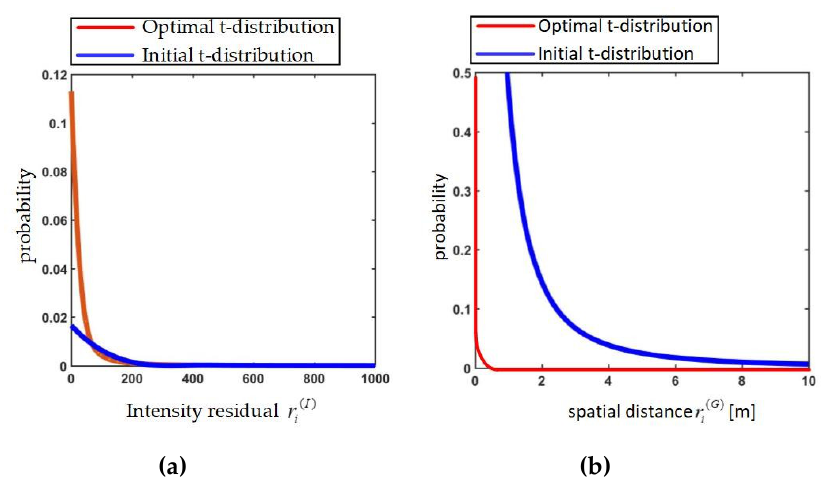
Figure 4. ( a ) The variance of optimal t-distribution about the intensity residuals is lower than that given by initial t-distribution. ( b ) The variance of optimal t-distribution about the spatial distances is lower than that given by initial t-distribution.